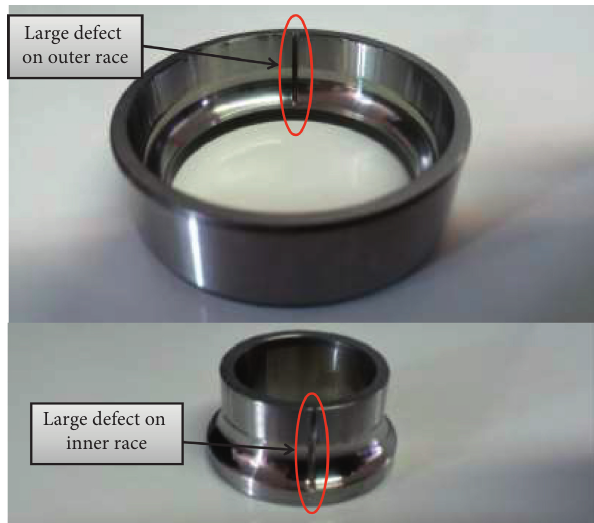
Figure 4: Defects caused in outer race of the bearing. Table 1: Specifications of defects. Type of defects